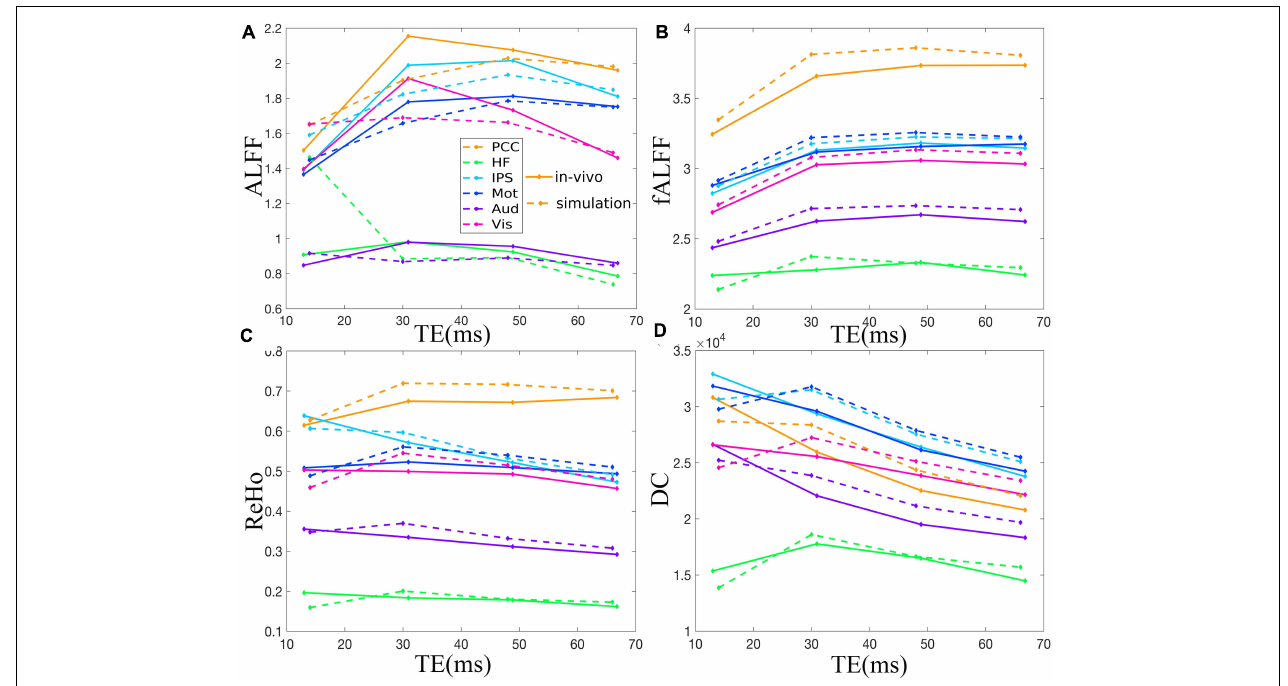
FIGURE 5 | Comparison between simulation and in vivo value of ALFF (A) , fALFF (B) , ReHo (C) , and DC (D) of six ROIs, i.e., PCC, HF, IPS, Mot, Aud, and Vis, across all subjects under eyes closed condition. The solid and dotted lines denote the in vivo and simulation results, respectively. ALFF, amplitude of low-frequency fluctuation; fALFF, fractional ALFF; ReHo, regional homogeneity; DC, degree centrality; ROIs, regions of interest; PCC, posterior cingulate cortex; HF, left hippocampal formation; IPS, left intraparietal sulcus; Mot, left primary motor cortex; Aud, left auditory cortex; Vis, left primary visual